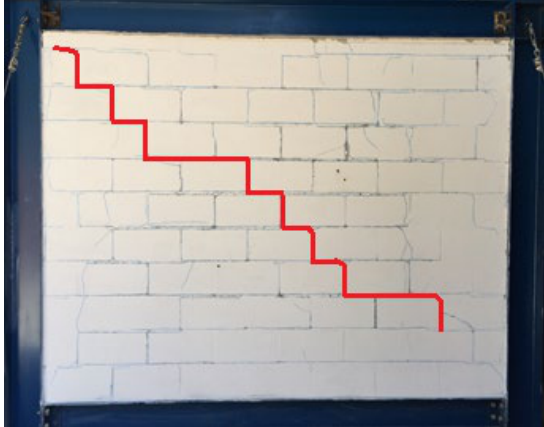
Figure 7. Typical masonry cracking after failure – PP-2-CE-0.5/2.0 (Highlighted in red: first crack register). Source: De Grandi